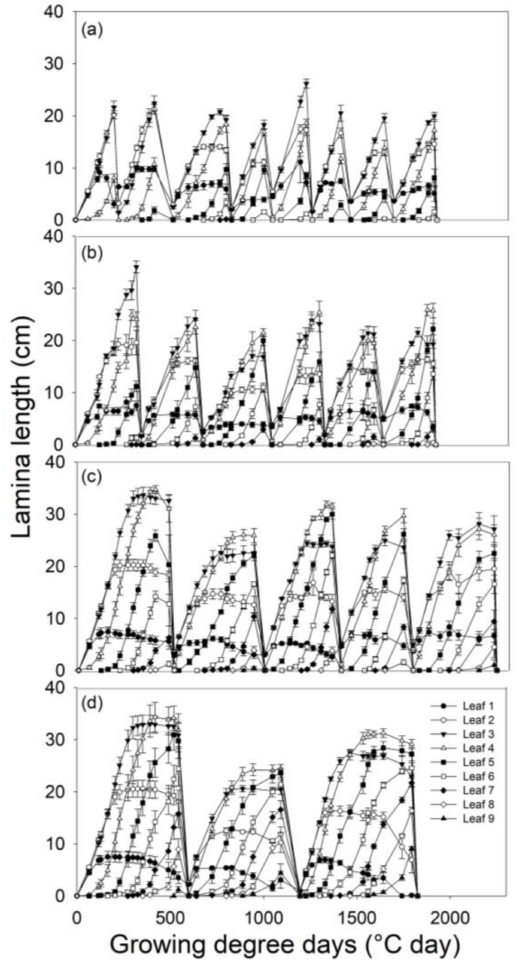
Figure 1. Tiller leaf growth dynamic and regrowth periods for each defoliation treatment for B. valdivianus . The defoliation frequencies were based on defoliation at ( a ) leaf stage 2 (LS-2); ( b ) leaf stage 3 (LS-3); ( c ) leaf stage 4 (LS-4); ( d ) leaf stage 5 (LS-5). Error bars: ± SEM ( n =